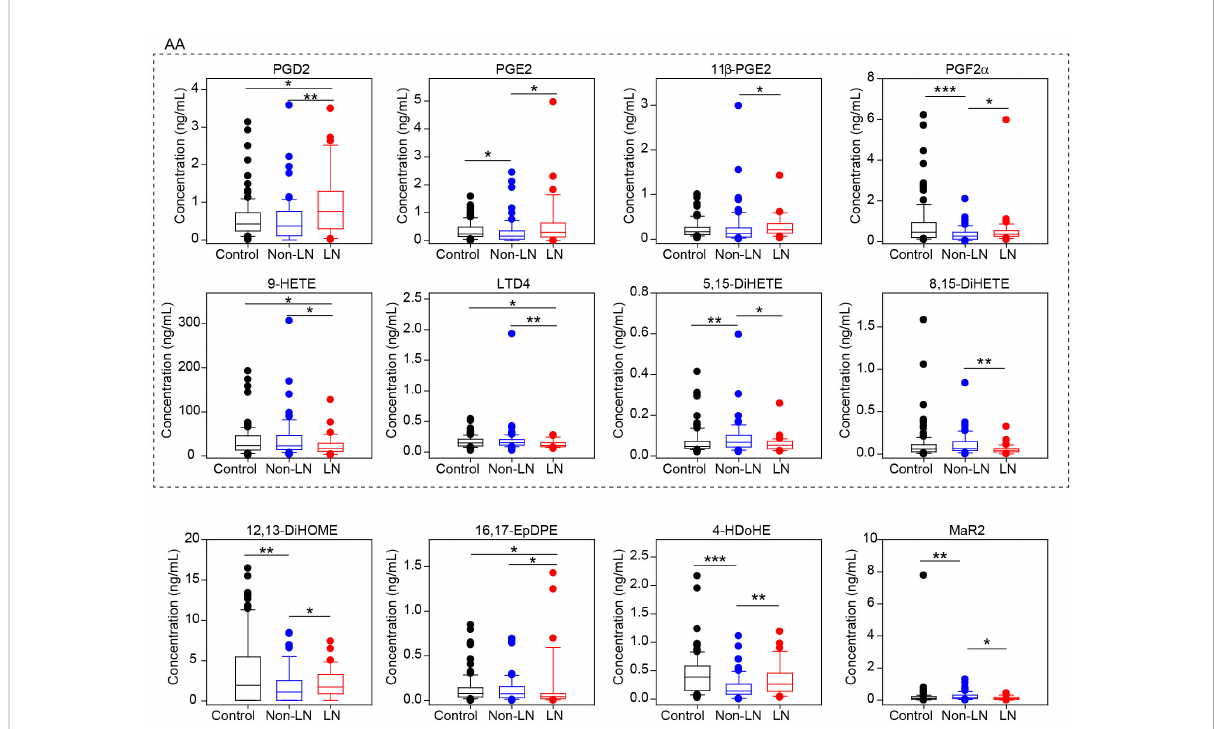
FIGURE 3 Different oxylipin metabolism between LN and non-LN patients. Box plots of 12 signi fi cantly different oxylipins between LN (n=33) and non-LN (n=65) patients. Dots represent outliers in each group. Control group is also included in this plot. The eight oxylipins in dashed box were all produced from AA. *, p-value<0.05; **, p-value<0.01 and ***, p-value<0.001 by student ’ s t test or rank-sum